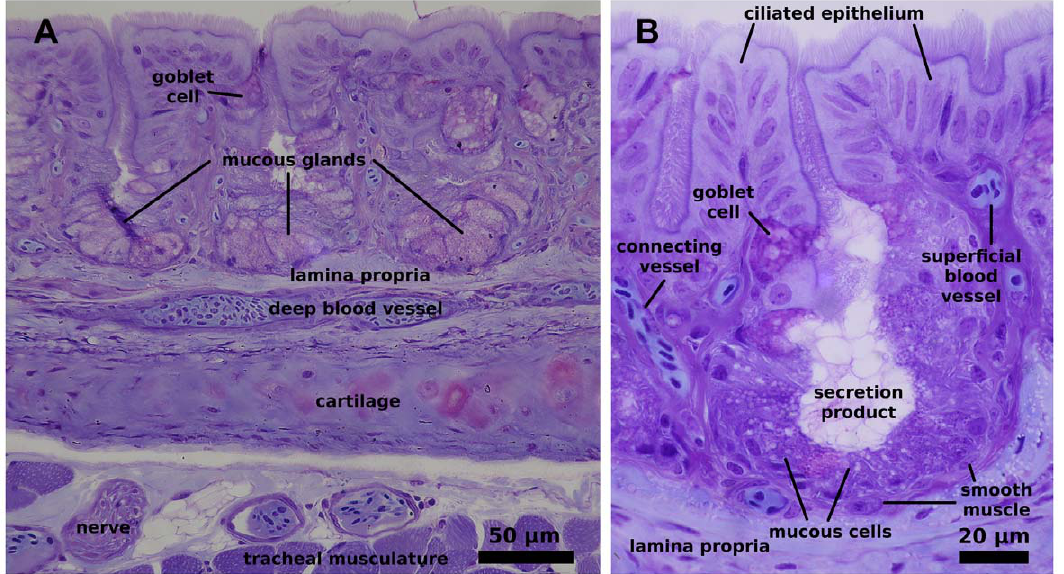
Figure 9. Histological structure of the chicken trachea. A) overview illustrating mucosa with alveolar mucous glands. Note interstitial connective tissue (lamina propria) between the glands contains many blood vessel profiles. The deep vascular layer lies between the tracheal cartilage and the mucosa. B) detail of an alveolar mucous gland showing goblet cells (only one indicated) at its entrance. Note the proximity of the most superficial blood vessels to the luminal surface of the ciliated epithelium. Scale indicated by bars. Staining of 2 m m thick sections with 0.1% toluidine blue.